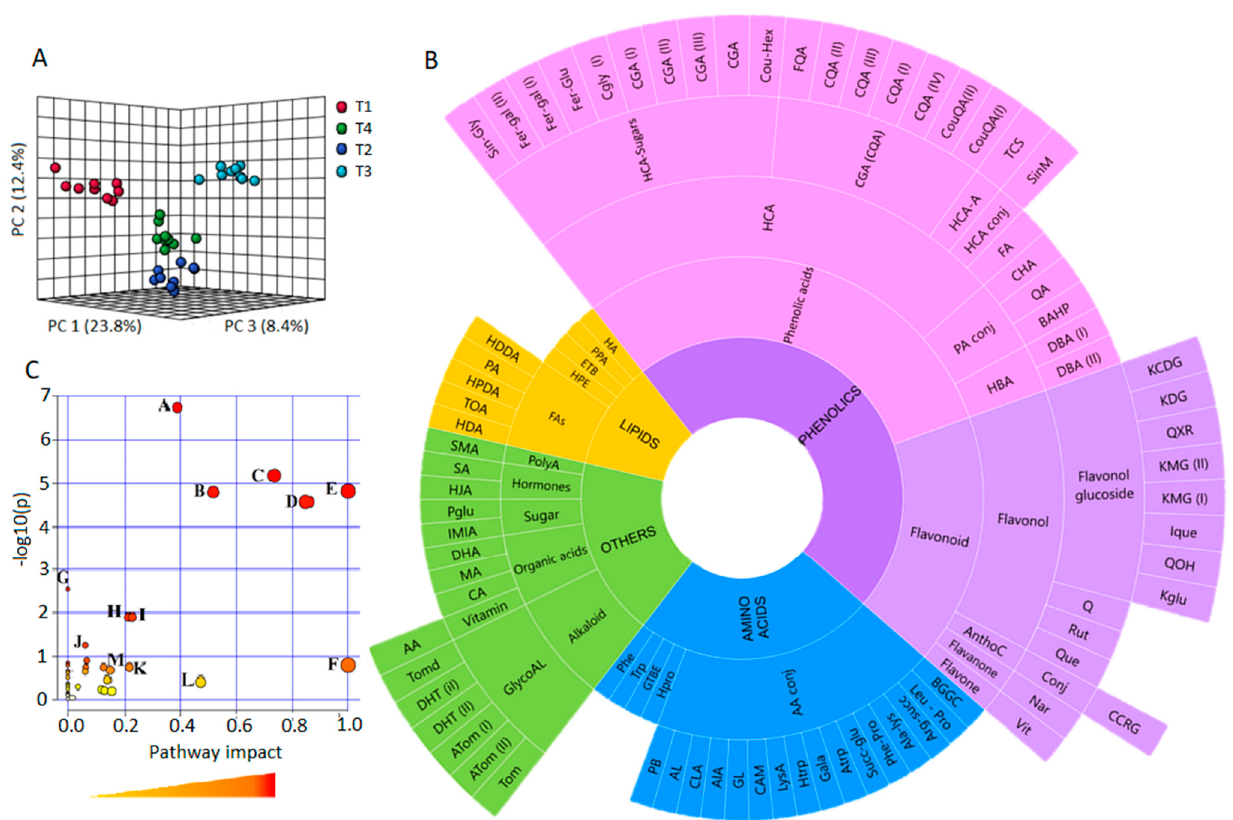
Figure 2. An overview of the metabolome coverage and metabolic changes associated with Si-biostimulant treatment of salt stressed plants. ( A ) The 3-dimensional PCA scores plot with 44.6% of 58.5% total explained variation between the non-stressed controls (T1: red), salt stressed (T2: dark blue), and the soil and foliar biostimulant treated stressed plants (T3: light blue and T4: green, respectively ( B ) A sunburst chart that summarises the overall metabolome covered in this study, displaying the main metabolite classes (amino acids, lipids, phenolics and others), their respective metabolites and conjugates. ( C ) The metabolome summary of pathway analysis shows the contribution of each pathway on biostimulant-induced metabolic changes. Node colour: significance of the pathway based on p-value (red is the most impactful). Node size: impact of each pathway, largest nodes represent pathways with the greatest impacts (See Table S3). Metabolite abbreviations are provided in Table S2.